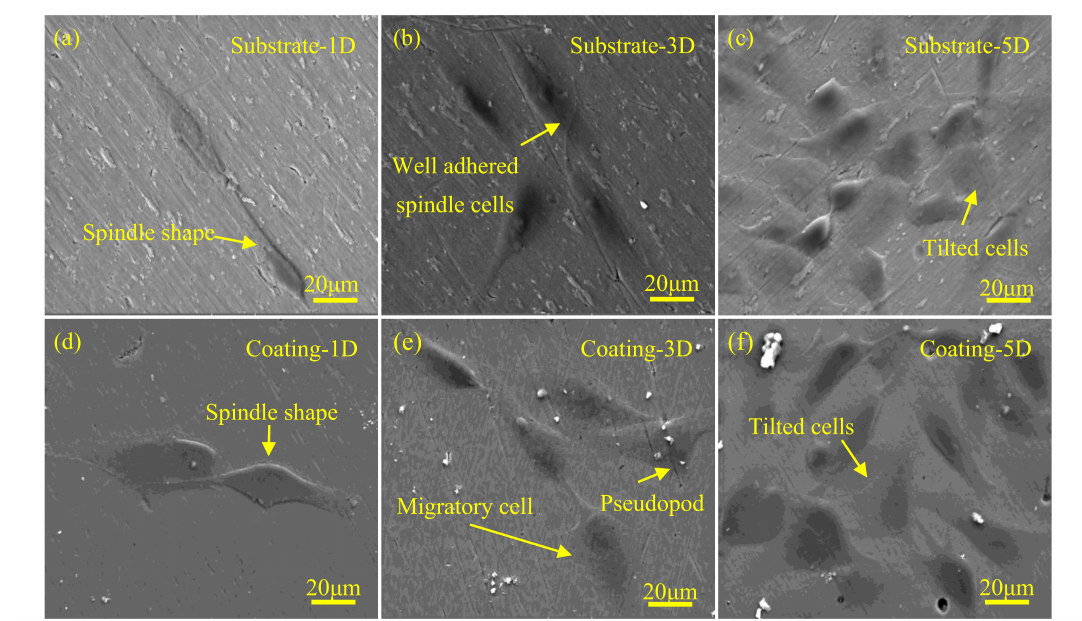
Figure 8. Morphology of MG-63 cells cultured on substrate ( a – c ) and coating ( d – f ) after 1, 3 and 5